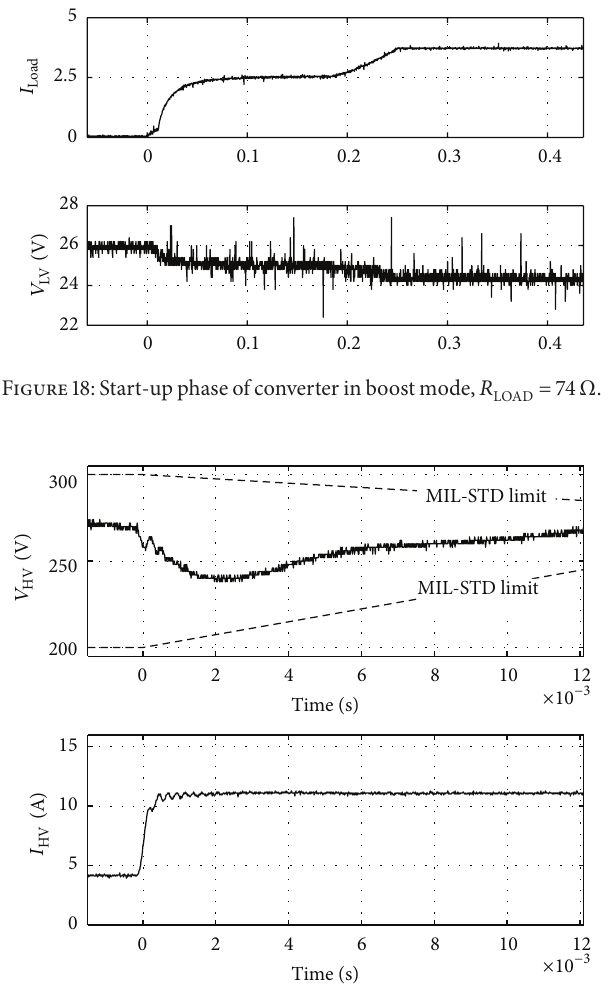
Figure 19: Boost test, variation of load: 1.5kW → 3 kW.